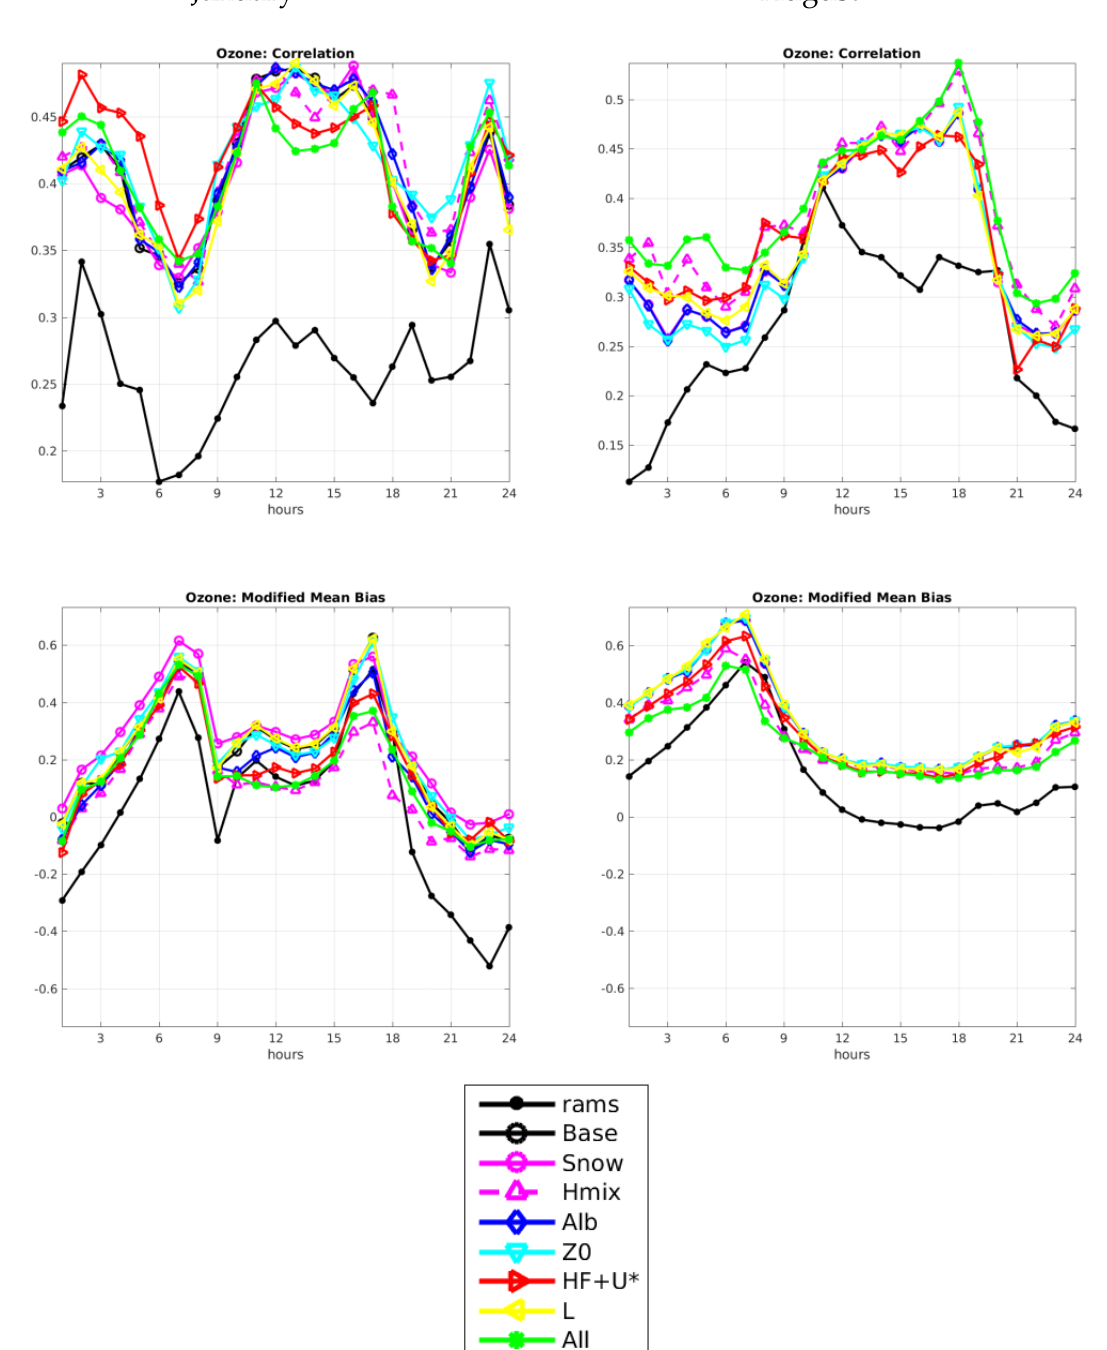
Figure 9. O 3 —R of hourly concentrations (upper panel), MMB of hourly concentrations (lower panel), for January (left column) and August (right column). The x -axis reports UTC times.